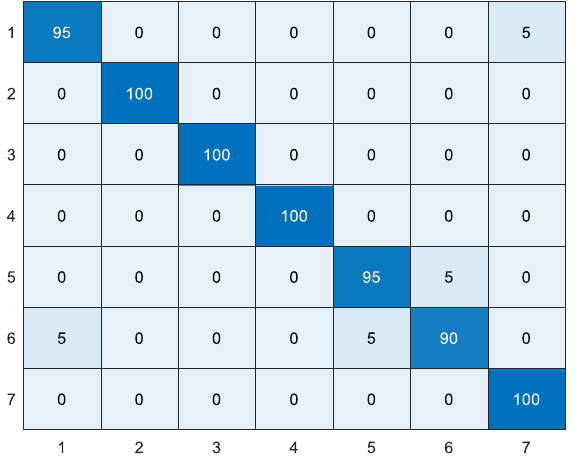
Figure 15. The confusion matrix obtained by WTLD_kirsch with SVM of linear kernel function of dataset 1 (%).